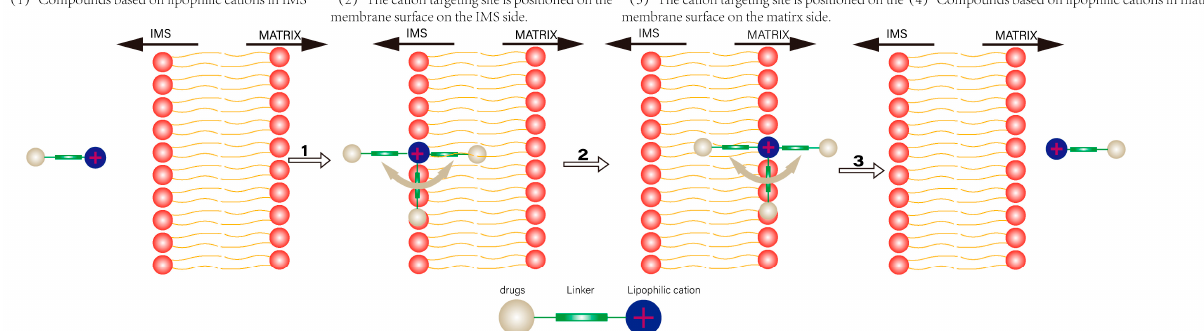
Figure 3. Schematic representation of the transport of a lipophilic cation carrying a drug from the mitochondrial intermembrane space (IMS) through the inner mitochondrial membrane to the mitochondrial matrix. Upon binding to the mitochondrial membrane, the cationic targeting group is localized on the membrane surface due to electrostatic interaction with negatively charged phosphate. The position of the linker and the drug will depend on their physicochemical properties. Lipophilic linkers and drugs will be localized in the center of the membrane, while hydrophilic drugs may be localized in the aqueous phase of the cell. For positively charged hydrophilic cargoes or linkers, it is possible that the molecule will “lie” on the surface of the membrane. As illustrated in Figure 3, (2) and (3).